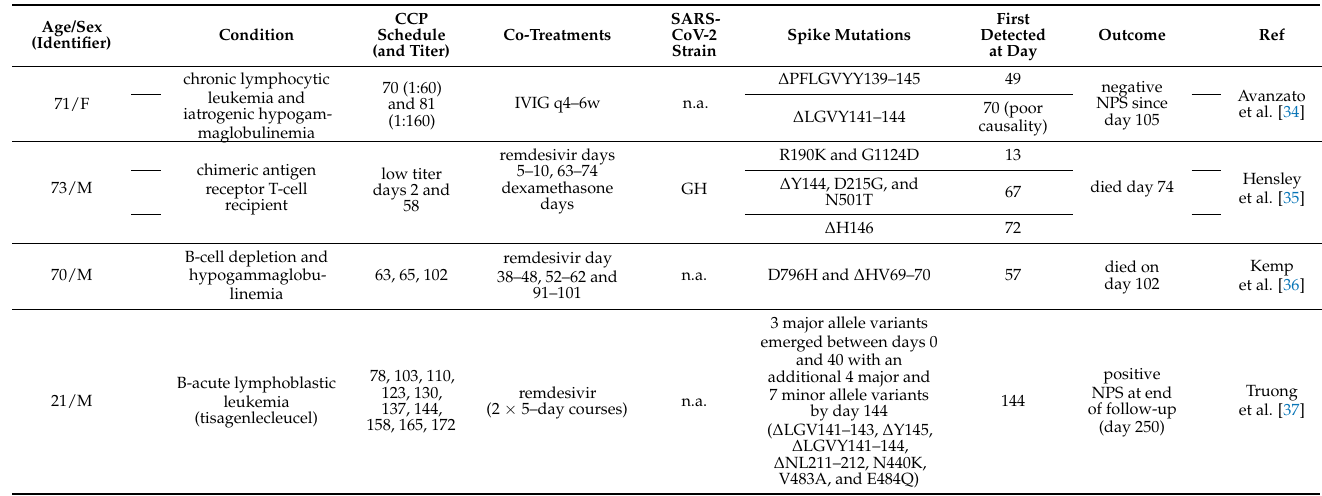
the (uncharacterized) polyclonal response. Table 3. Case reports of immune escape after CCP